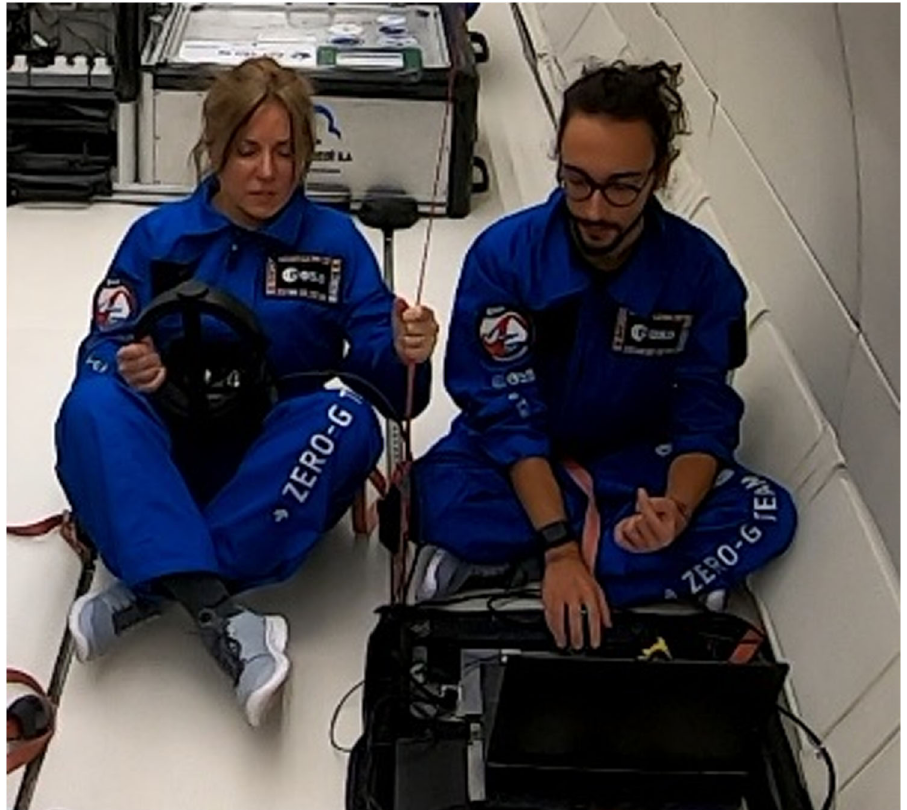
Fig. 4 Photo of the experimental set-up in fl ight. The participant was sitting cross-legged and fi rmly strapped to the fl oor at 60 cm from the screen of a laptop that was attached on the fl oor and centred on the sagittal mid-plane. The experimenter in charge of administering the experimental task and supervising its execution was positioned on the right side of the participant, slightly further back so as not to interfere with task